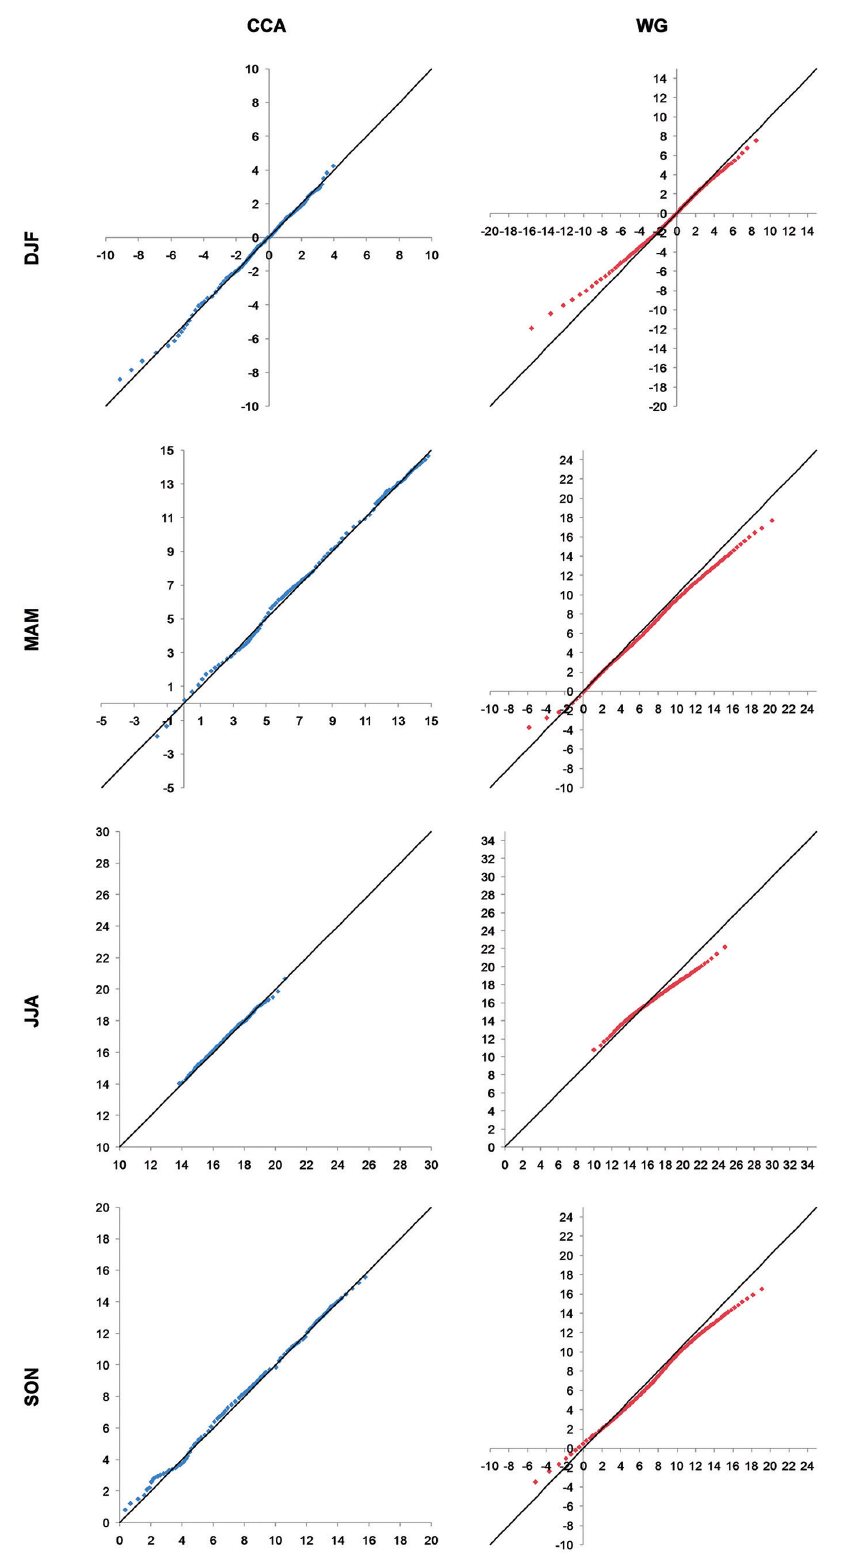
Fig. 4. Q-Q plot of the mean air temperature (°C) in several seasons (DJF – winter, MAM – spring, JJA – summer, SON – au- tumn) by CCA and WG models in Poland in the period 1971–2000 (x-axis – measured values, y-axis – modeled